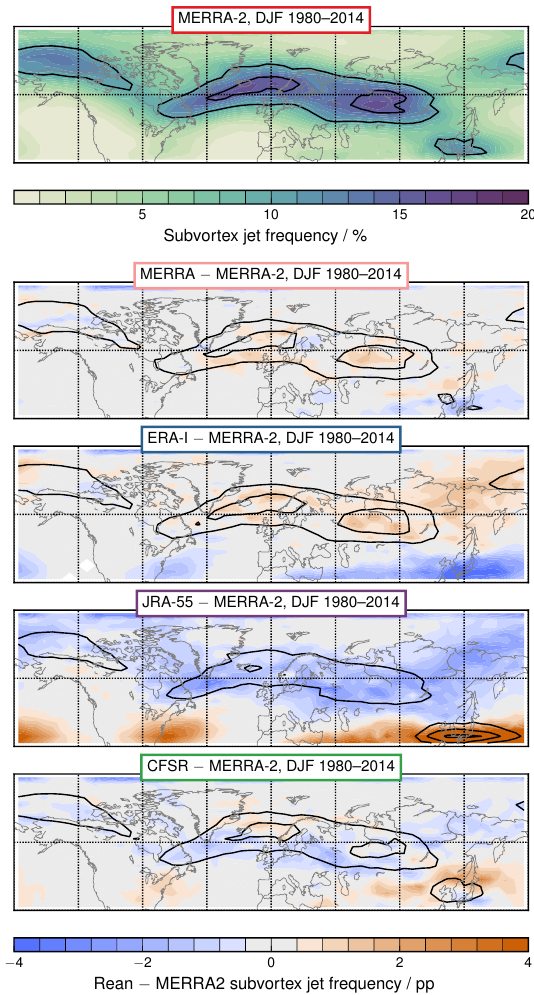
Figure 11. As in Fig. 7, but for NH subvortex jet frequency distribu- tions in DJF. The latitude domain shown is north of 30 ◦ N. Overlaid contours are frequencies of 10, 15, and 20% for each reanalysis; the smallest value is always the largest or “outermost” contour. In the difference plots, blues/oranges indicate negative/positive differ-